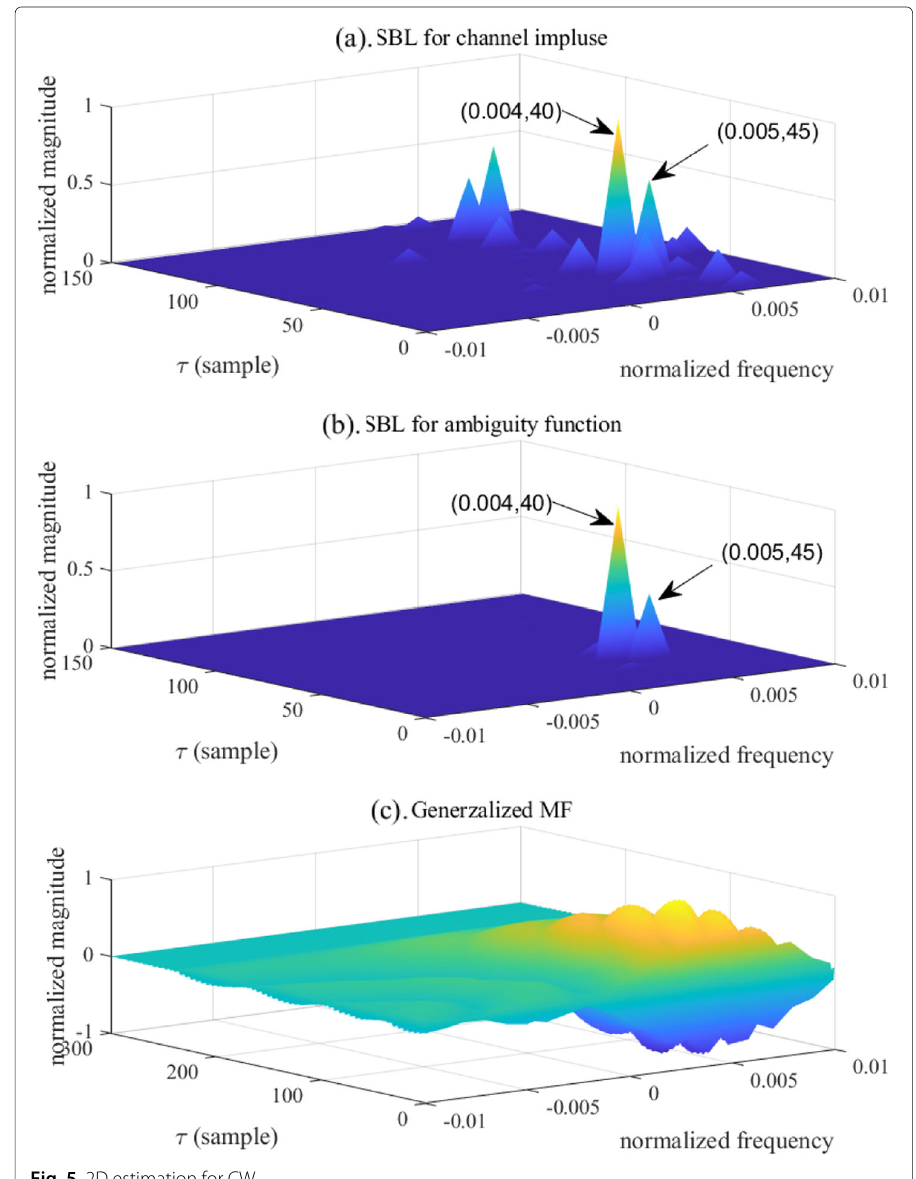
Fig. 5 2D estimation for CW